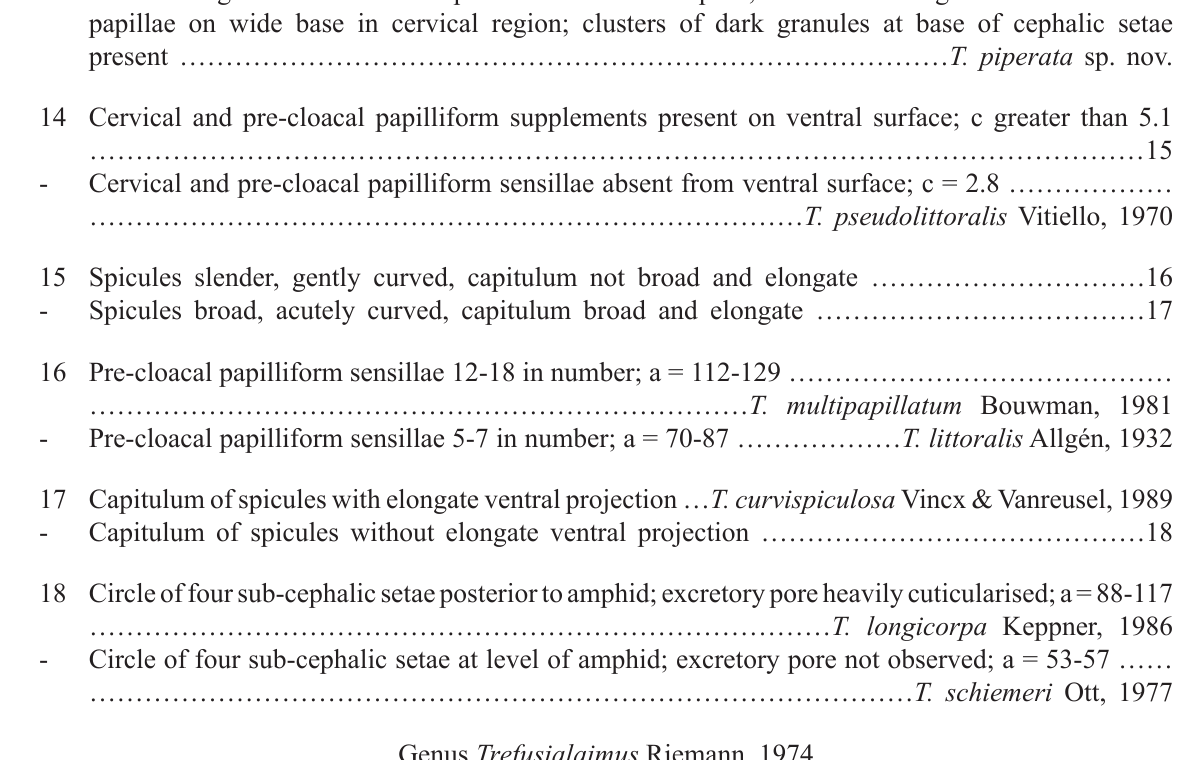
cervical and pre-cloacal papilliform sensillae absent from ventral surface; c = 2.8